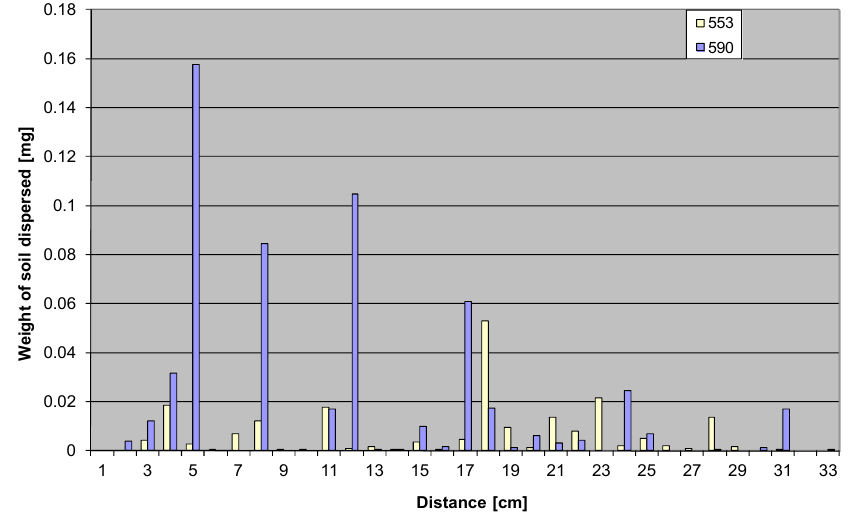
Figure 15. Weight of soil dispersed by splash in relation to the distance of the waterdrop impact.